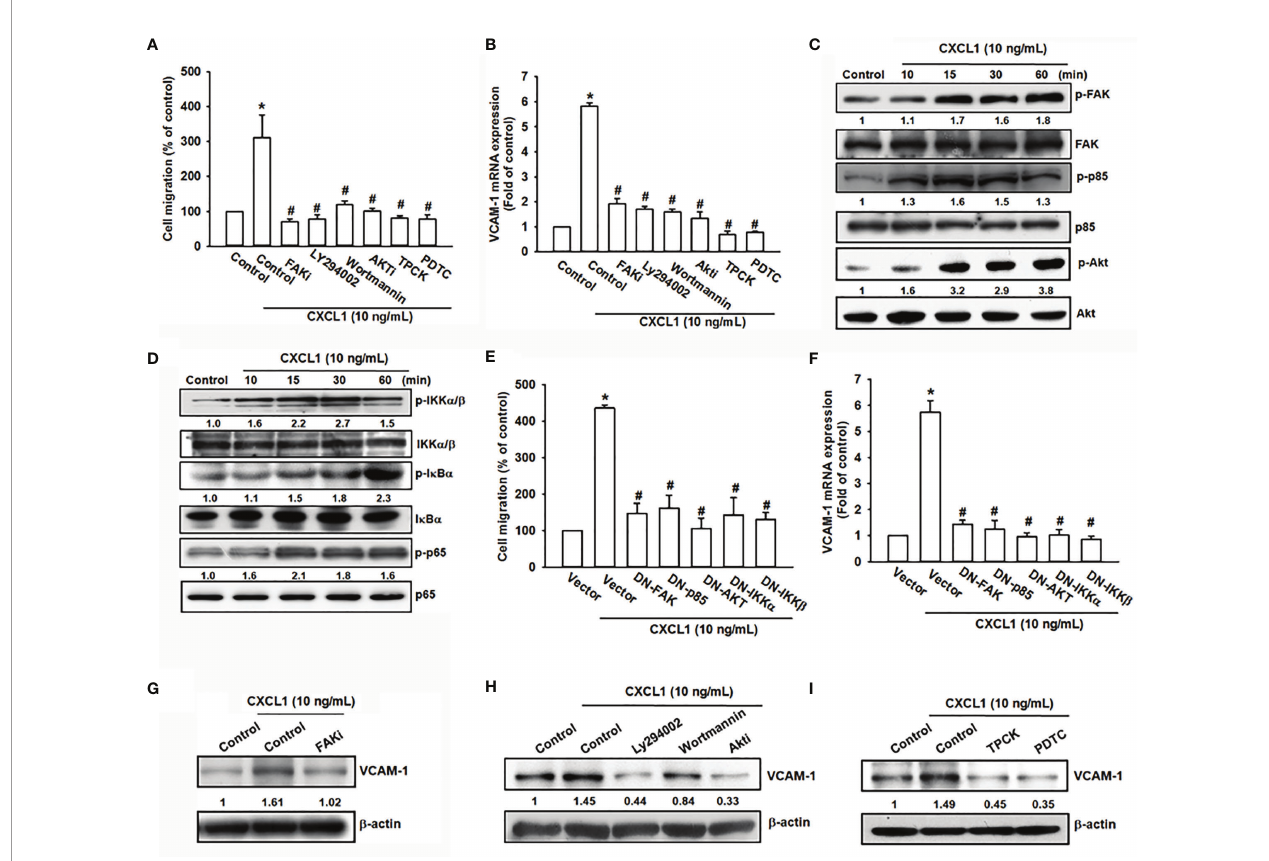
FIGURE 4 | The FAK, PI3K, Akt, and NF- k B pathways are involved in CXCL1-promoted migration and VCAM-1 expression in MG63 osteosarcoma cell. (A, B) CXCL1-increased cell migration and VCAM-1 mRNA expression could be reduced by pre-treated FAK inhibitor (2 m M), PI3K inhibitors LY294002 (5 m M) and wortmannin (2 m M), Akt inhibitor (5 m M), and NF- k B inhibitors TPCK (5 m M) and PDTC (1 m M) for 90 min. (C) Phosphorylated levels of FAK, P85, and Akt, and (D) phosphorylated levels of IKK, I k B a , and p65 were examined by immunoblotting assay in MG-63 cells with CXCL1 incubation for the indicated time intervals (0, 10, 15, 30, or 60 min). (E, F) Transfecting dominant-negative mutants of FAK, PI3K, Akt, and IKK for 24 h could suppress CXCL1 increased cell migration and VCAM-1 mRNA expression. (G – I) FAK, PI3K, Akt, and NF- k B inhibitors reduced CXCL1-induced VCAM-1 protein expressions. The data were collected from at least three individual experiments and expressed as mean ± S.D. * p < 0.05 as compared to the control group; # p < 0.05 compared with the CXCL1-treated control or vector